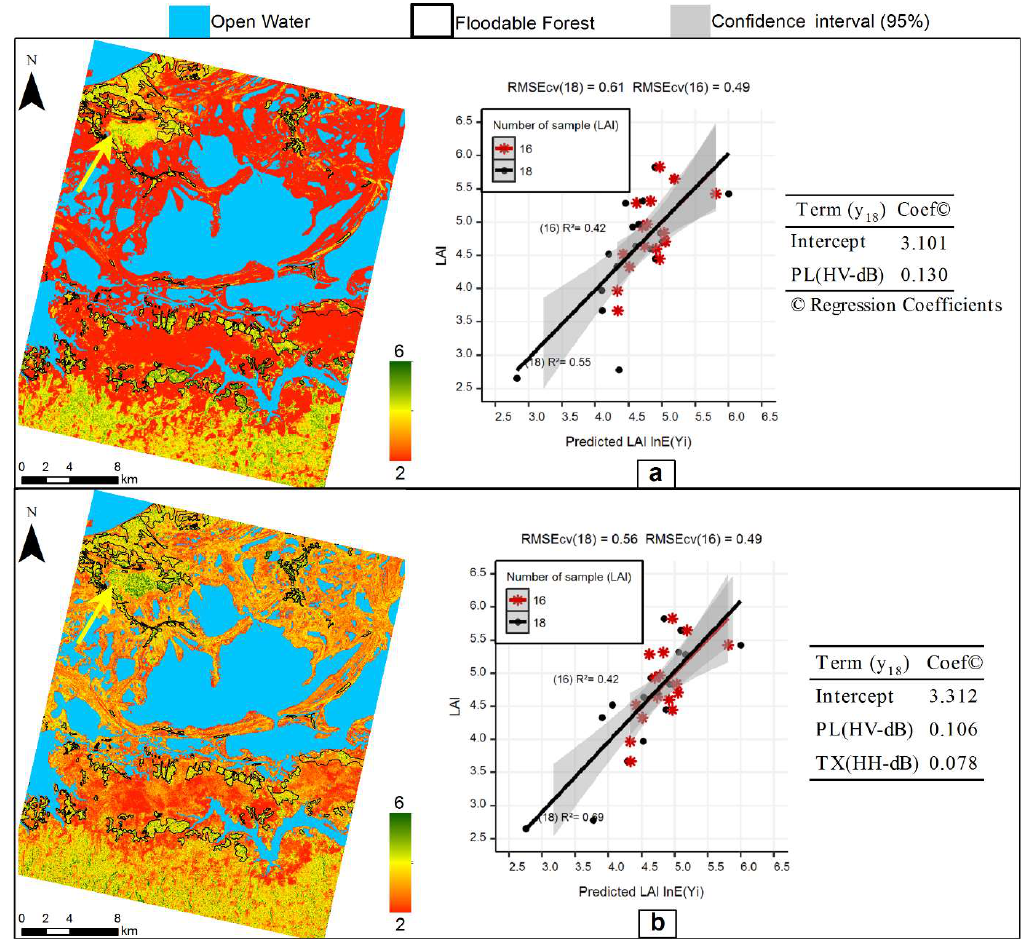
Figure 7. Comparison of predicted and observed values of LAI and spatial prediction for the models: ( a ) PL-FBD+TX 18 ; ( b ) PL-FBD 18 . The yellow arrow indicates some high-density shrubby areas. Central Amazon Floodplain, Brazil.